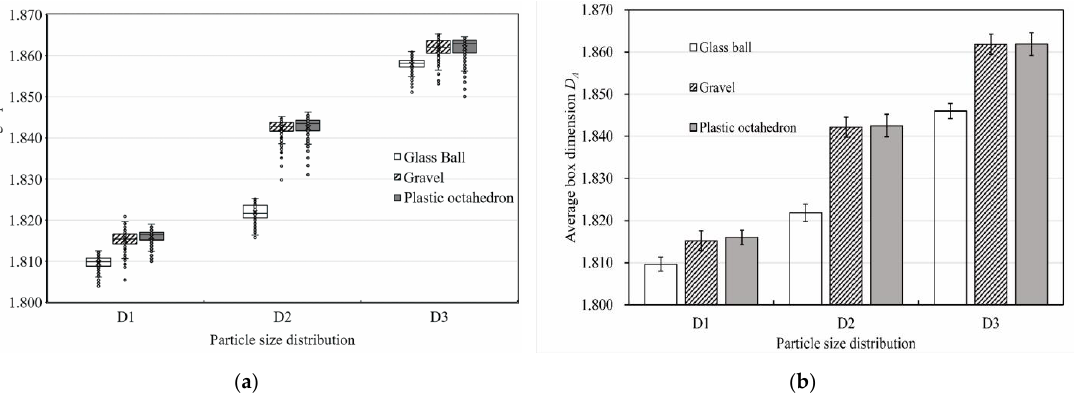
Figure 11. Box dimensions of the pore–particle interfaces. ( a ) The box plot of the box dimensions of single particles’ pore–particle interfaces. ( b ) The bar graph of the packs’ average box dimensions. The figure’s error lines were based on the standard deviation.